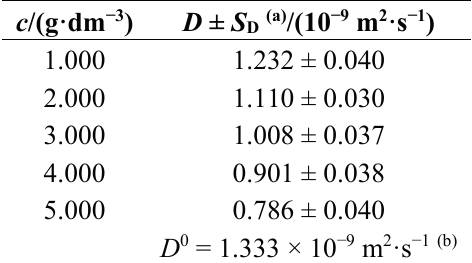
Table 2. Mutual diffusion coefficients, D , of NaHy aqueous solutions at different concentrations and the respective standard deviations, S D , obtained from the Taylor technique by using pure water as carrier stream, at T = 25 °C and at atmospheric